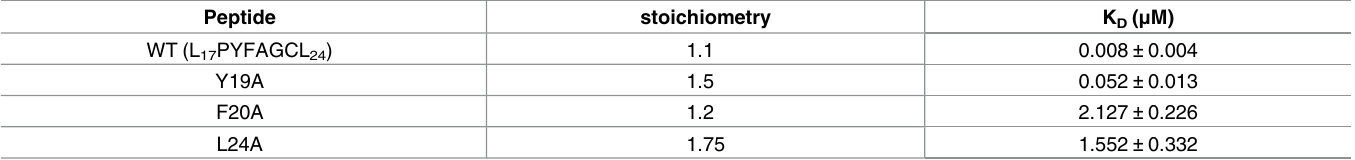
Table 2. Binding on ComR of WT and variants XIPs as measuredby ITC. Peptide